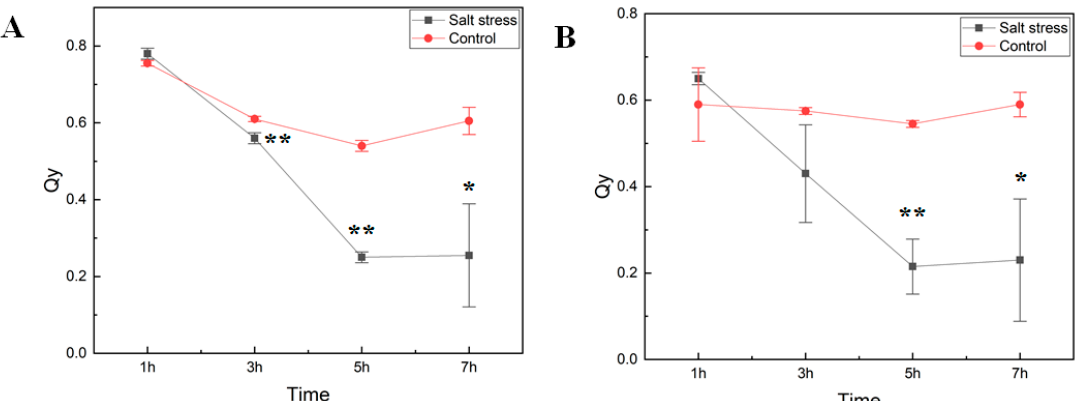
Figure 1. Photosynthetic efficiency of photosystem II. The maximal quantum yield of photosystem II (PSII) photochemistry (Fv/Fm) ( A ) and the efficiency of excitation capture of the open PSII center (Fv ’ /Fm’) ( B ) in cv . Crimson Sweet leaves under salt stress were measured using FluorPen (PAR-FluorPen FP 110/D). Asterisks ** and * represent significant difference at p < 0.05 and p < 0.1, respectively. Qy, equal to Fv/Fm in the dark ( A ) or light-adapted ( B ) samples, photosystem II efficiency. The error bars represent the standard deviation.